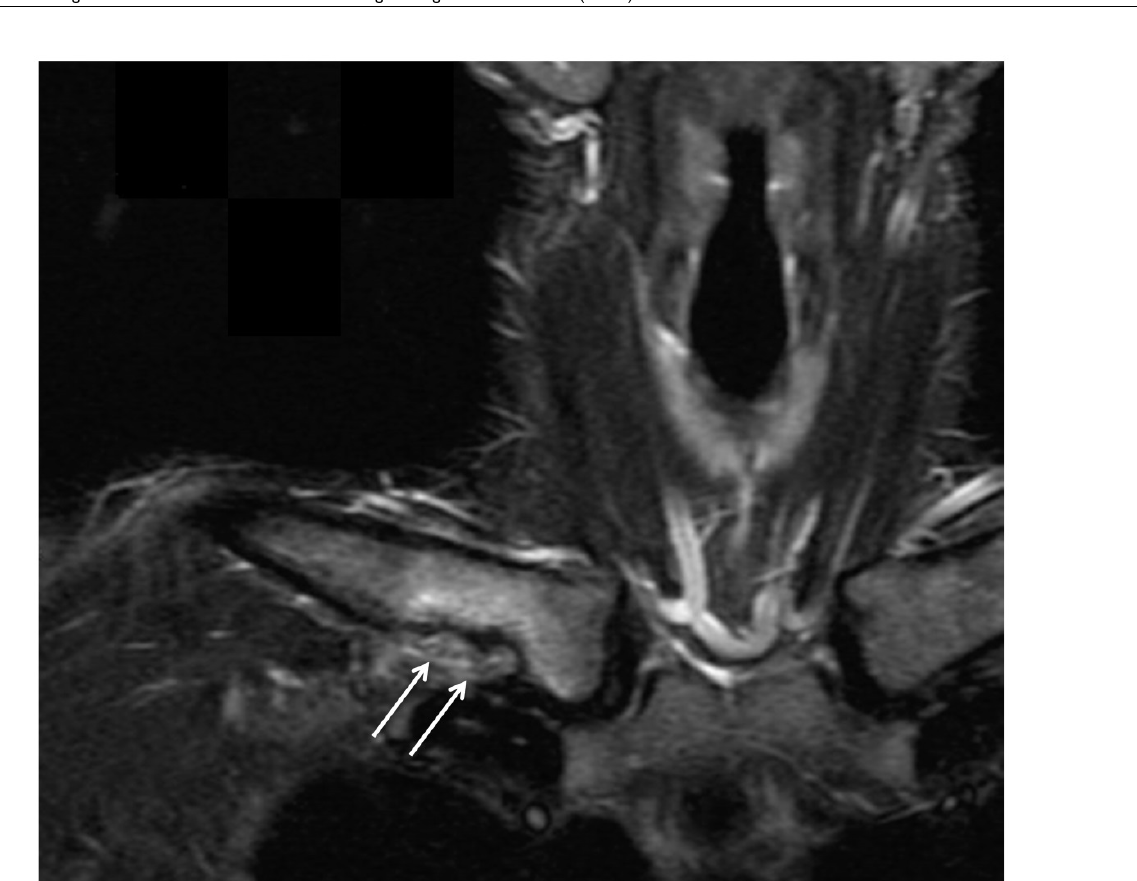
Figure 10. Coronal T2-weighted MR scan shows bone marrow edema, erosions and phlegmon inferior to medial clavicle